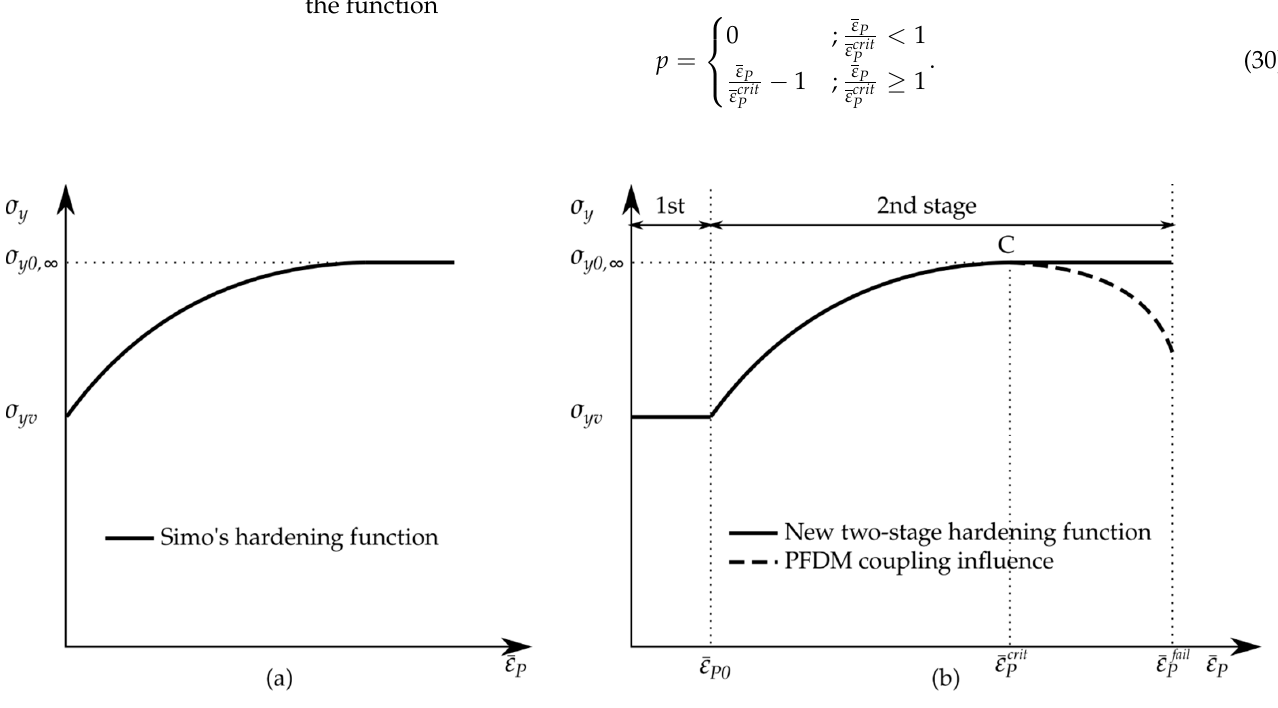
Figure 3. Yield stress of current yield surface σ y vs. equivalent plastic strain ε P diagram for metallic materials: ( a ) the Simo’s hardening function Equations (27) and (36), ( b ) the proposed new two-stage hardening function for simulation of metallic materials with or without plateau after yielding occurs ( σ yv —the initial yield stress, σ y 0, ∞ —the saturation hardening stress, ε P 0 —the maximal equivalent plastic strain for perfect plasticity stage, ε crit failure equivalent plastic